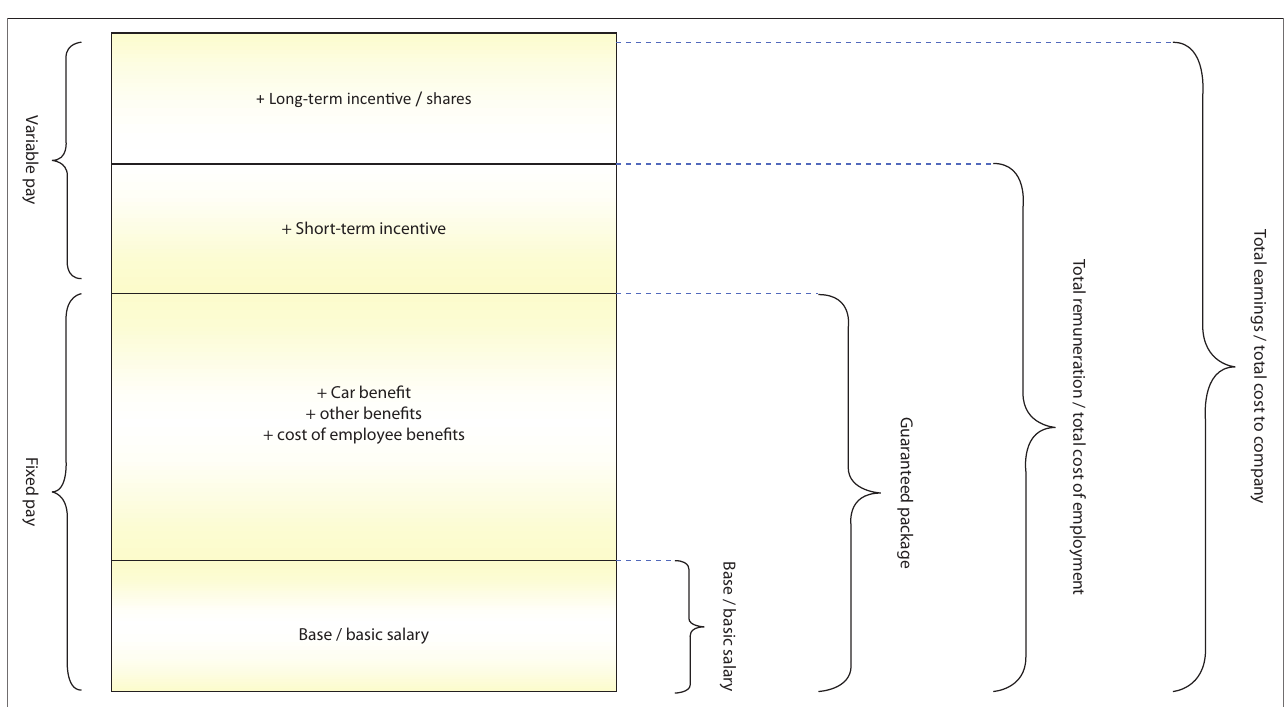
FIGURE 1: Components of chief executive officer compensation in South Africa (Bussin